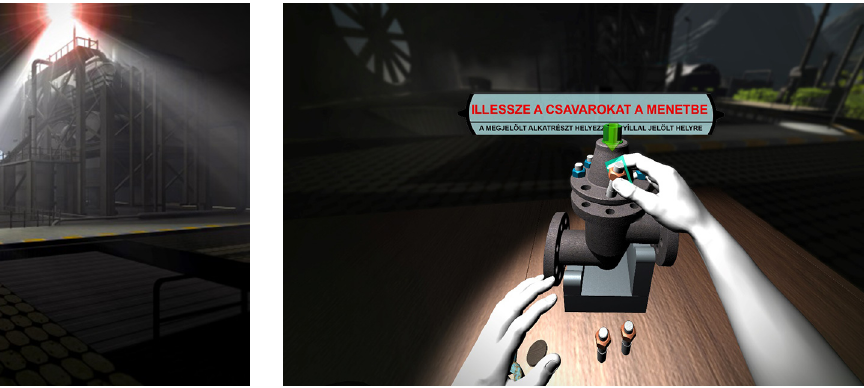
Fig. 1. VR trainig platform. Fig. 2. Virtual maintance of a valve